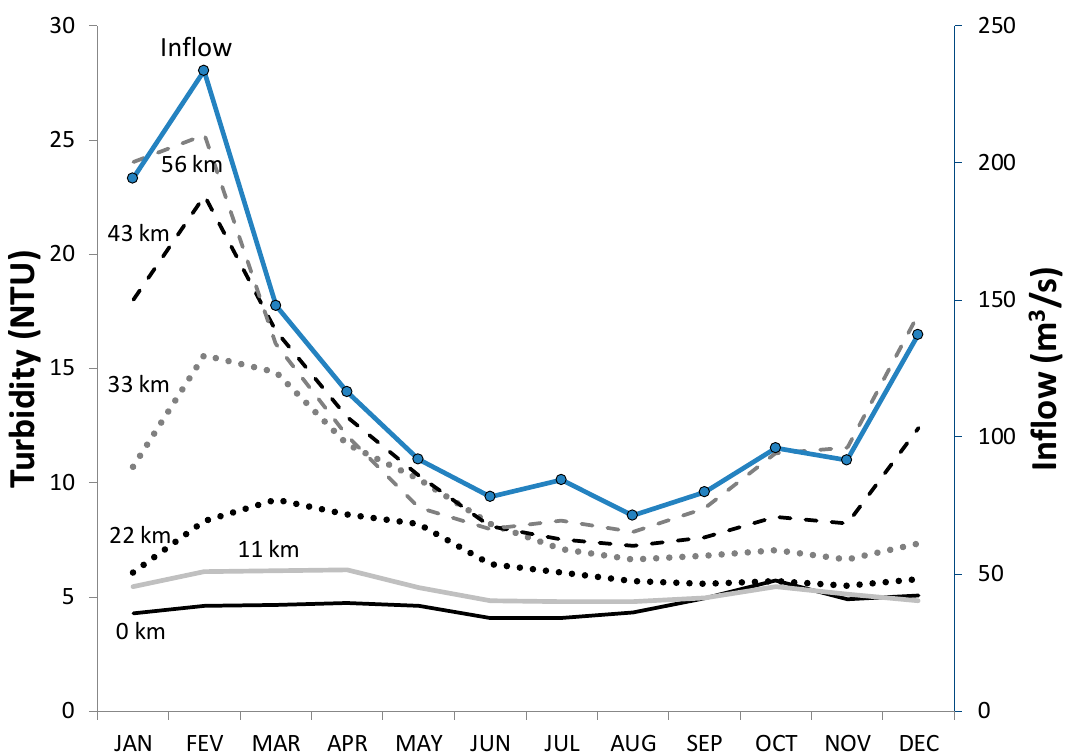
Figure 6. Water input and monthly averaged remote sensing-derived turbidity retrieved from 2000 to 2013 for six different virtual stations of reservoir #I. The distance of each virtual station to the reservoir impoundment is expressed in kilometers.